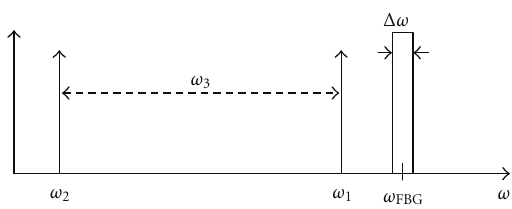
Figure 1: The relationship between the reflection spectrum of the FBG and the two optical